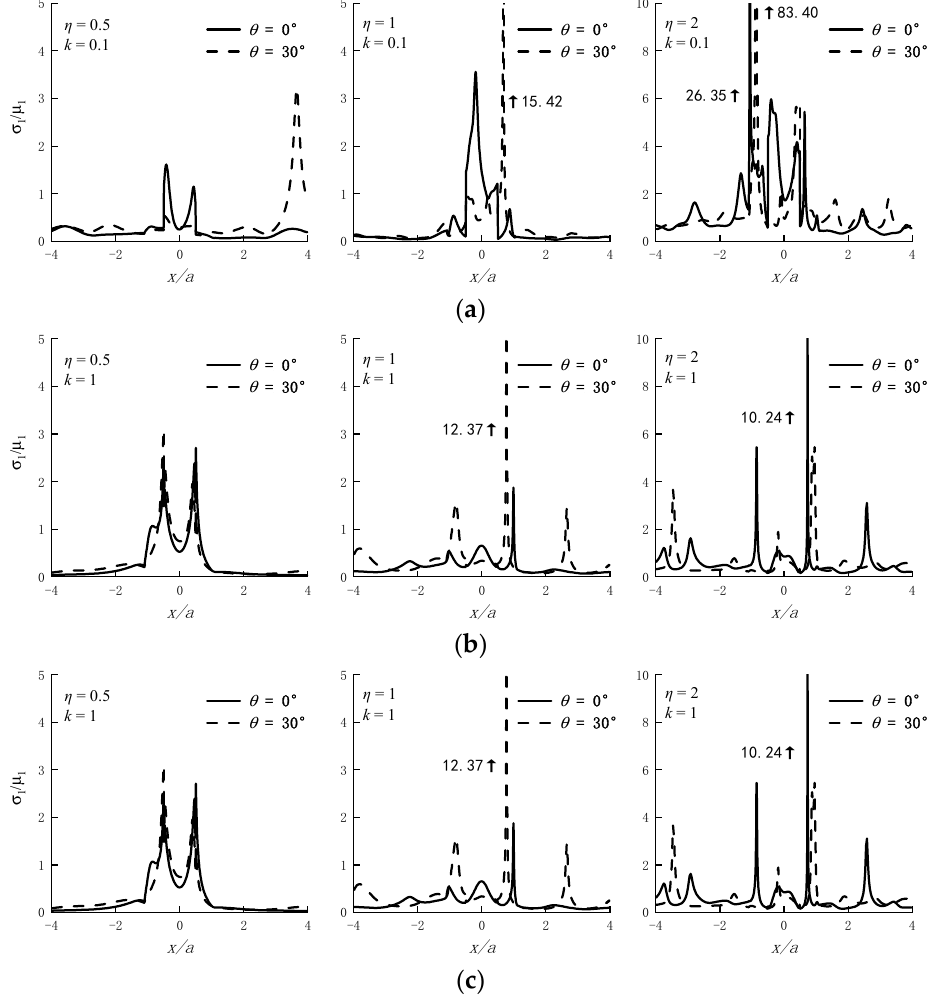
Figure 10. Horizontal surface amplitude displacement under random boundary (𝜃 = 0°) . ( a ) 𝑘 = 0.1 ; ( b ) 𝑘 = 1 ; ( c ) 𝑘 = ∞ .